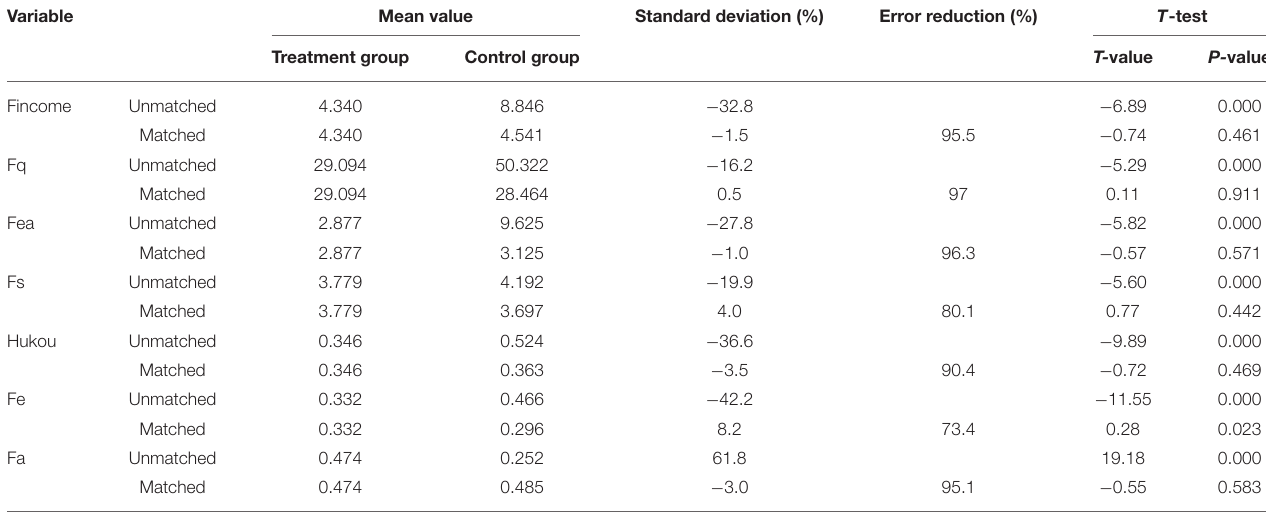
TABLE 5 | Balance diagnostics of matching variables.